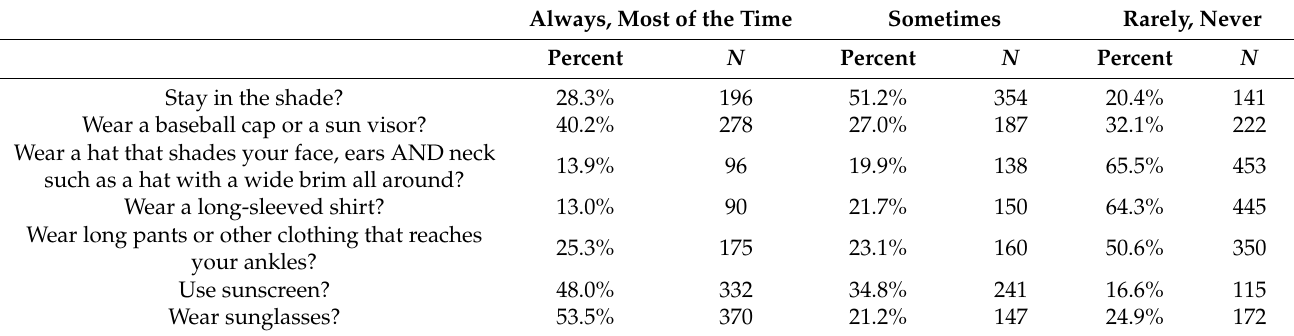
Table 4. Participants’ sun protective behavior when in the sun for > an hour ( n =